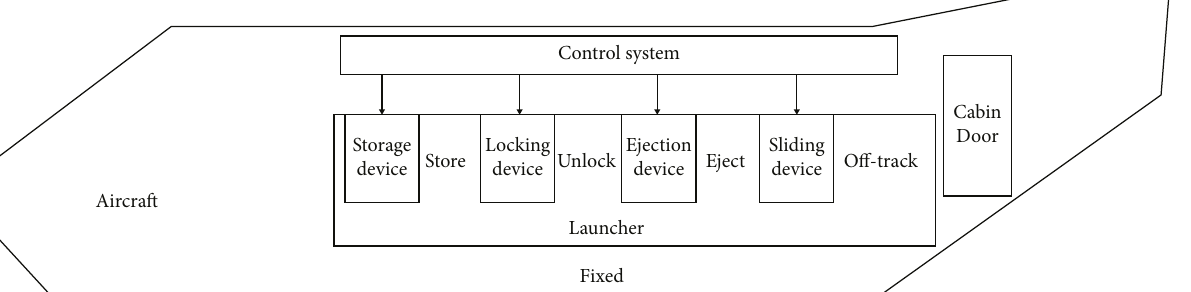
Figure 3: Main structure topology diagram of aircraft missile launching system.